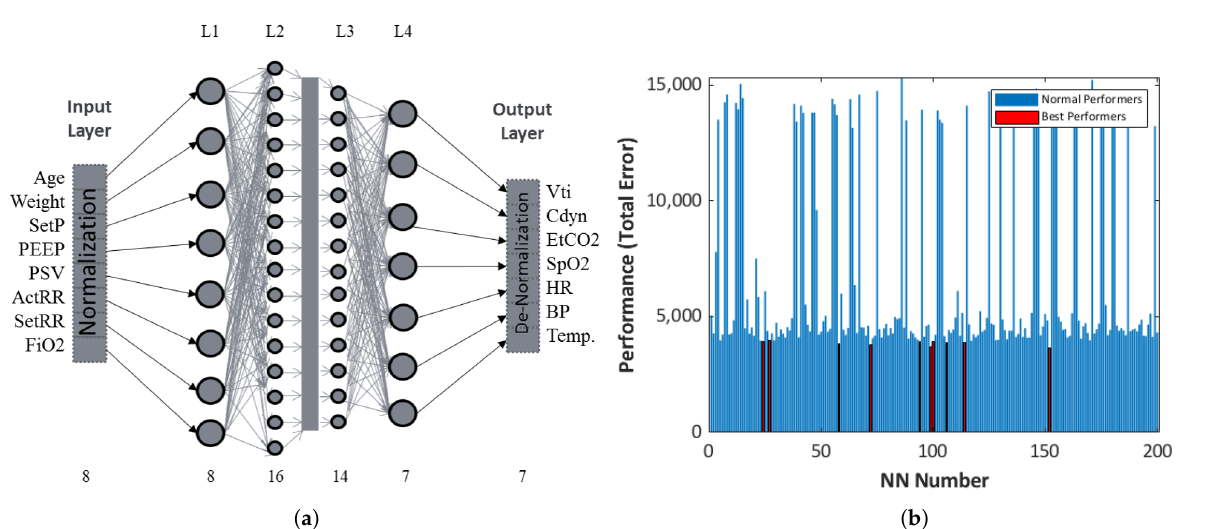
Figure 3. ( a ) Artificial neural network schema mapping ventilator parameter and patient outcomes. ( b ) Performance of different neural networks over 200 trials. Red represents the best performers that showed the lowest combined training, validation, and testing errors.